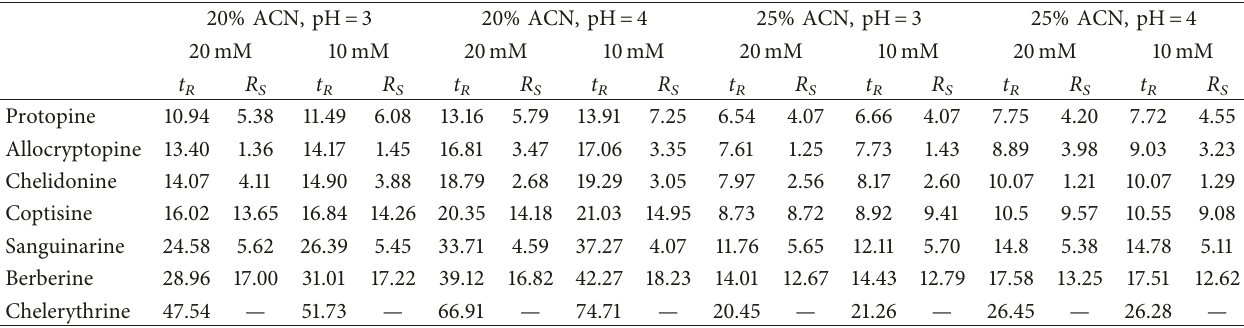
Table 1: The comparison of retention times and peak resolutions of investigated alkaloids in 20–25% of acetonitrile in water at different pH and ammonium acetate concentrations.